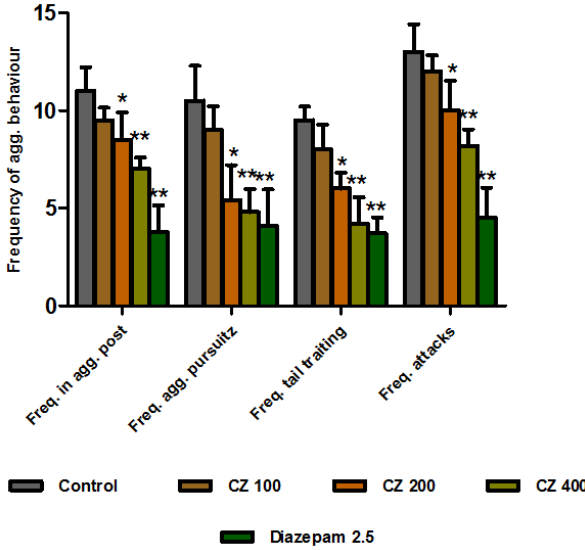
Fig. 2. Effect of EECZ on latency time to isolation-induced first attack. Control = 6 and treatment extract n=6, * p <.01, ** p <0.001 compared to control